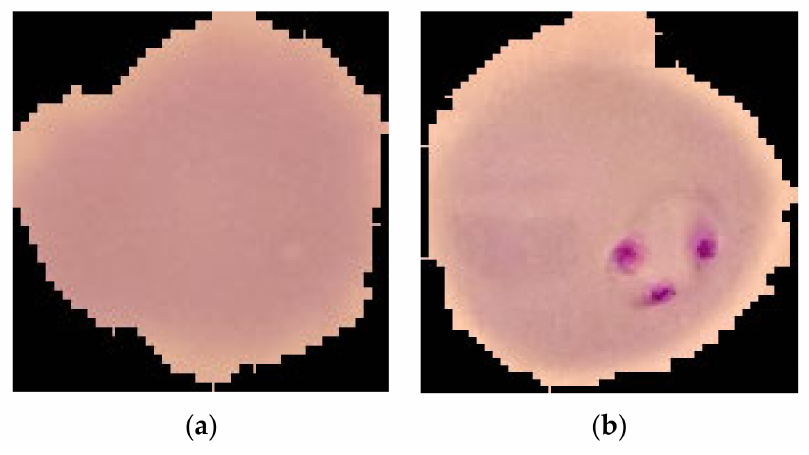
Figure 1. ( a ) Normal and ( b ) malaria-infected RBC